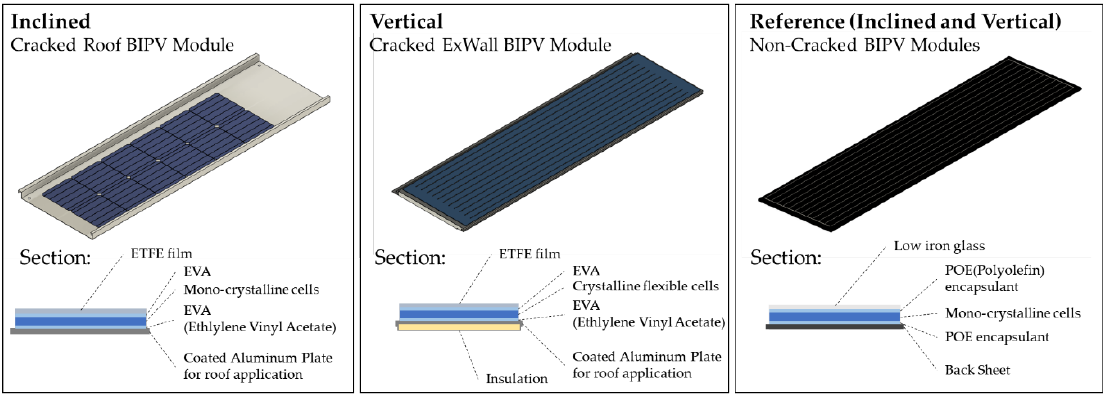
Figure 1. BIPV modules and their detailed sections .